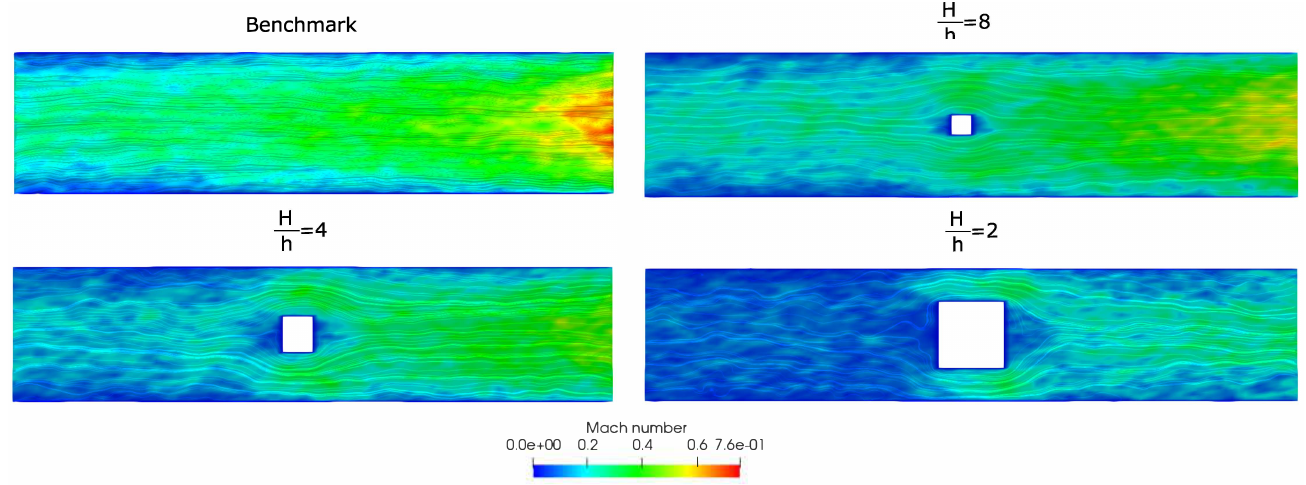
y plane for the −